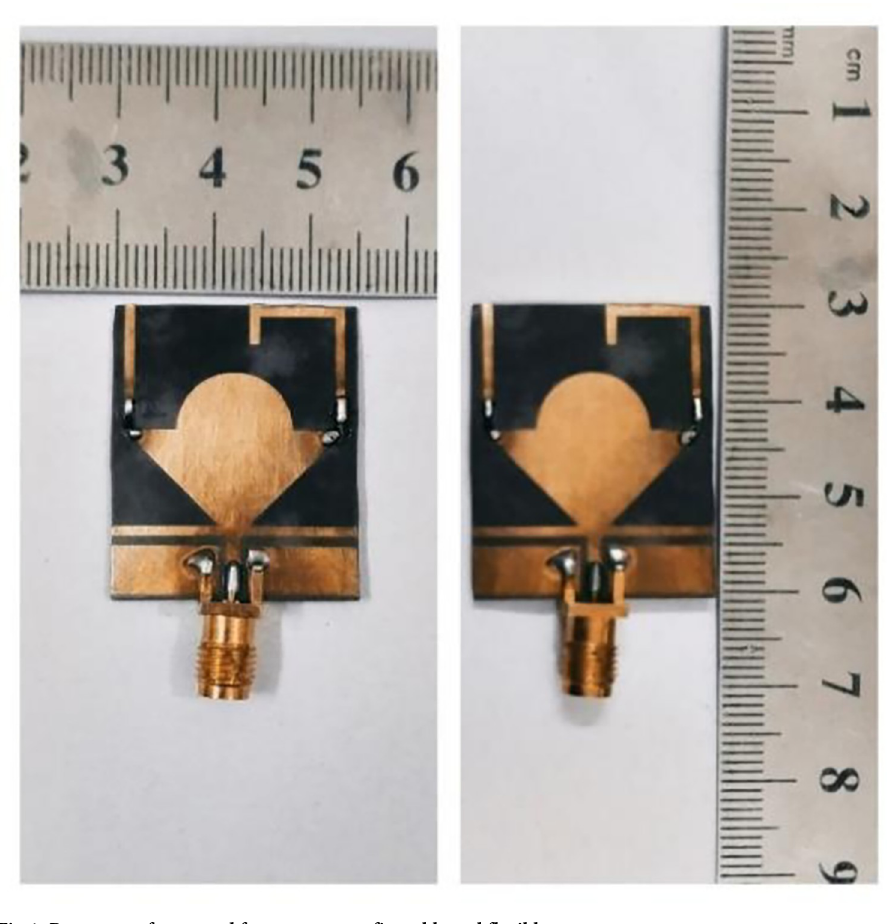
Fig 4. Prototype of proposed frequency reconfigurable and flexible antenna.